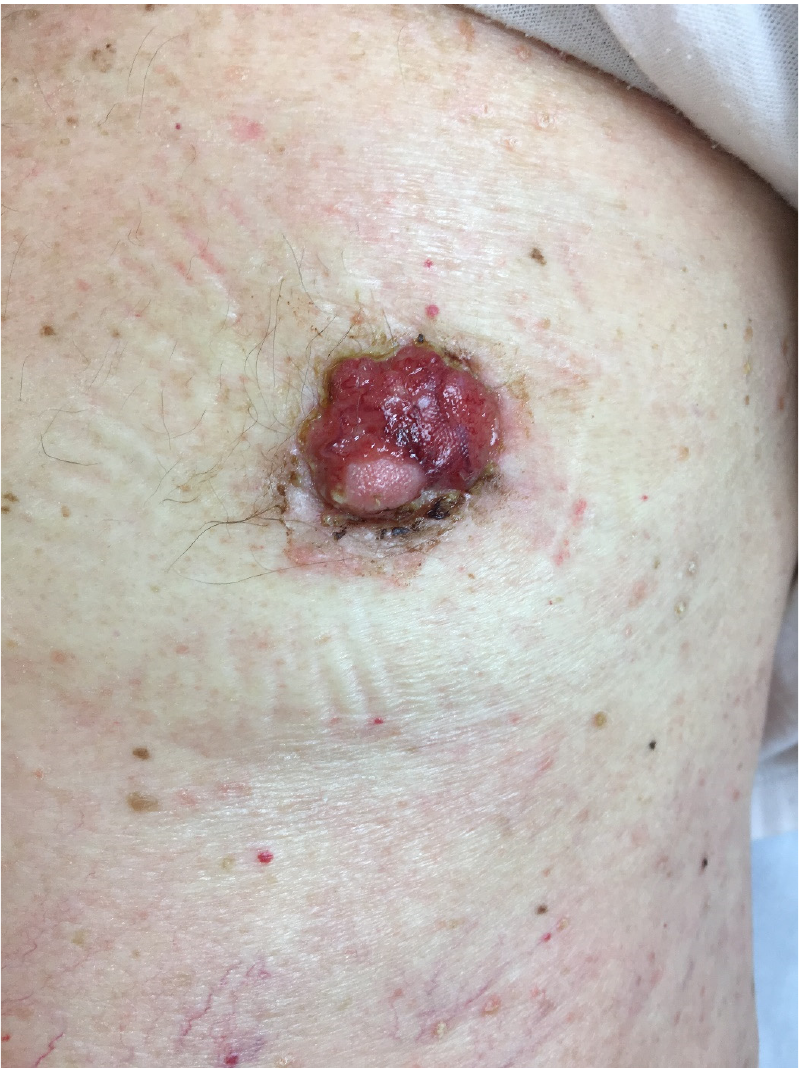
Figure 1. Enlarged left nipple-areola complex. Clinical appearance of BSCC on the nipple. Erosion on the surface represents the biopsy site. Dermoscopy showed absence of a pigment network and the presence of arborizing vessels, large blue-gray ovoid nests, multiple blue-gray globules, leaf-like areas, spoke wheel areas, and